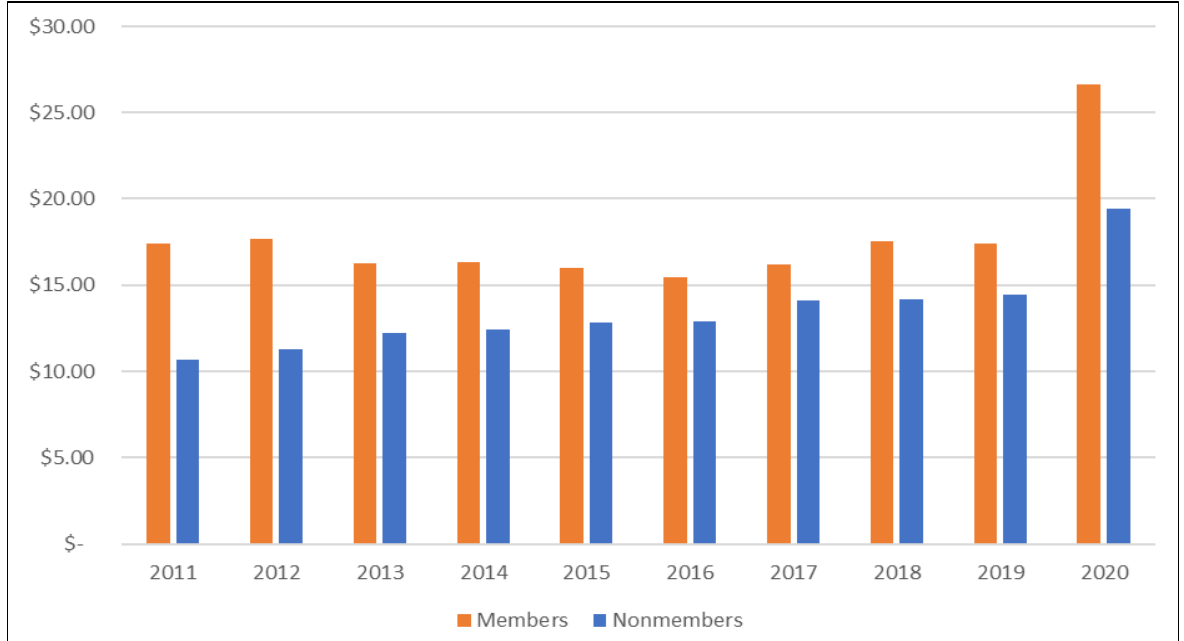
Figure 6. Average Value per Sales Receipt, Members vs. Nonmembers, 2011 –